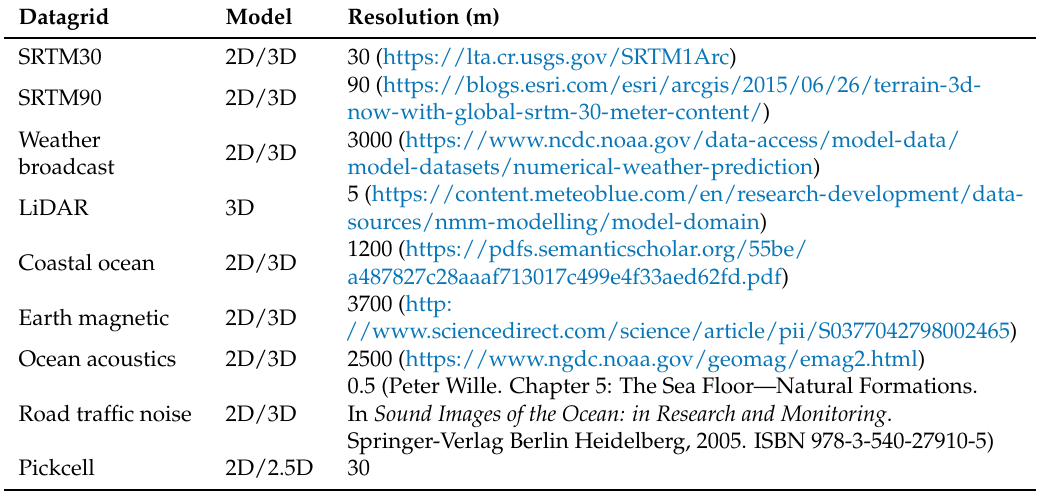
Table 4. A characterization of space and signal relations.